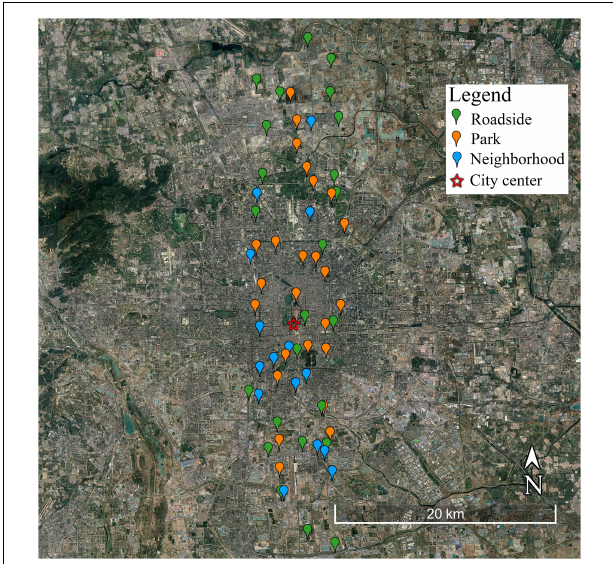
FIGURE 1 | Study area and sampling sites (background image from Google